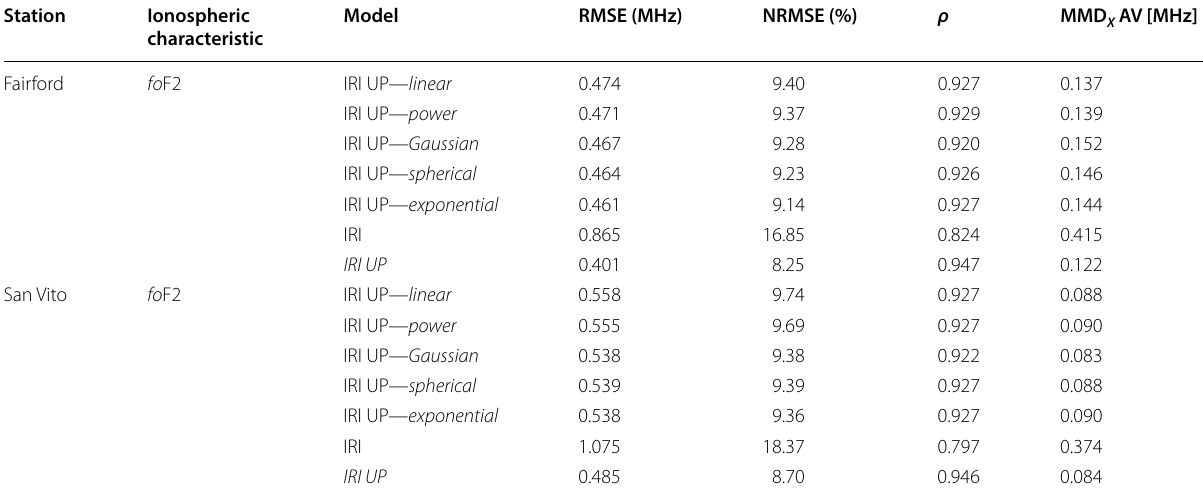
Statistical results for fo F2 obtained at the two truth sites of Fairford and San Vito for: IRI, IRI UP running with a fixed variogram model (IRI UP— variogram model chosen in the table), and IRI UP embedding the NQCR procedure (italics)